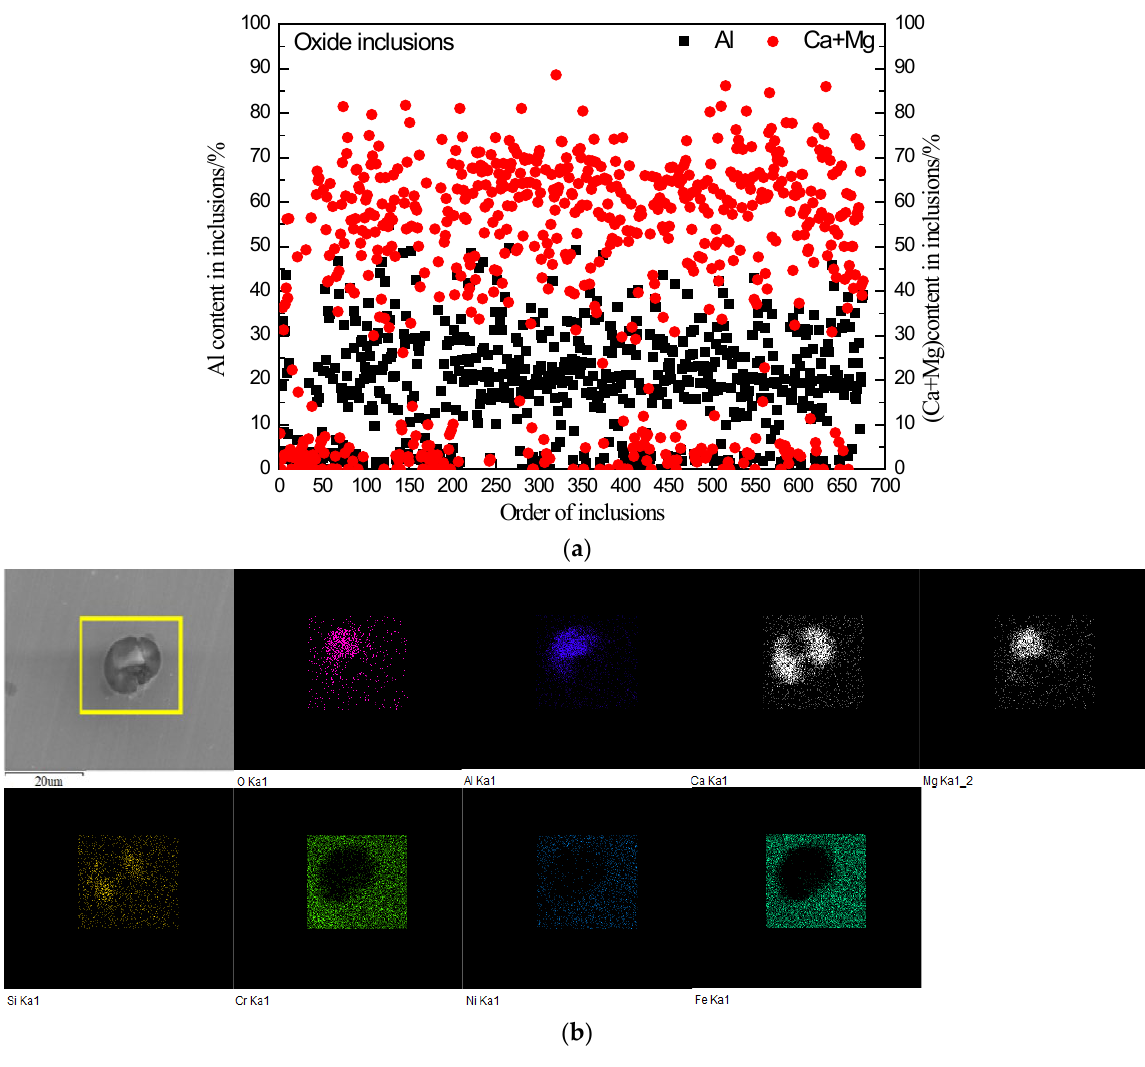
Figure 5. Composition and morphology of oxides in the consumable electrode. ( a ) Composition of oxide inclusions. ( b ) Morphology and composition distribution of typical inclusions.